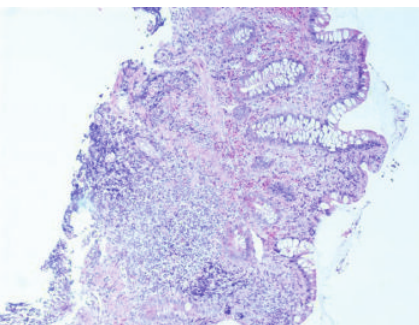
Figure 3: Irregular mucosa with inflammatory cell infiltrate com- posed of neutrophils and eosinophils which can be difficult to distinguish from preexisting inflammatory disorders.